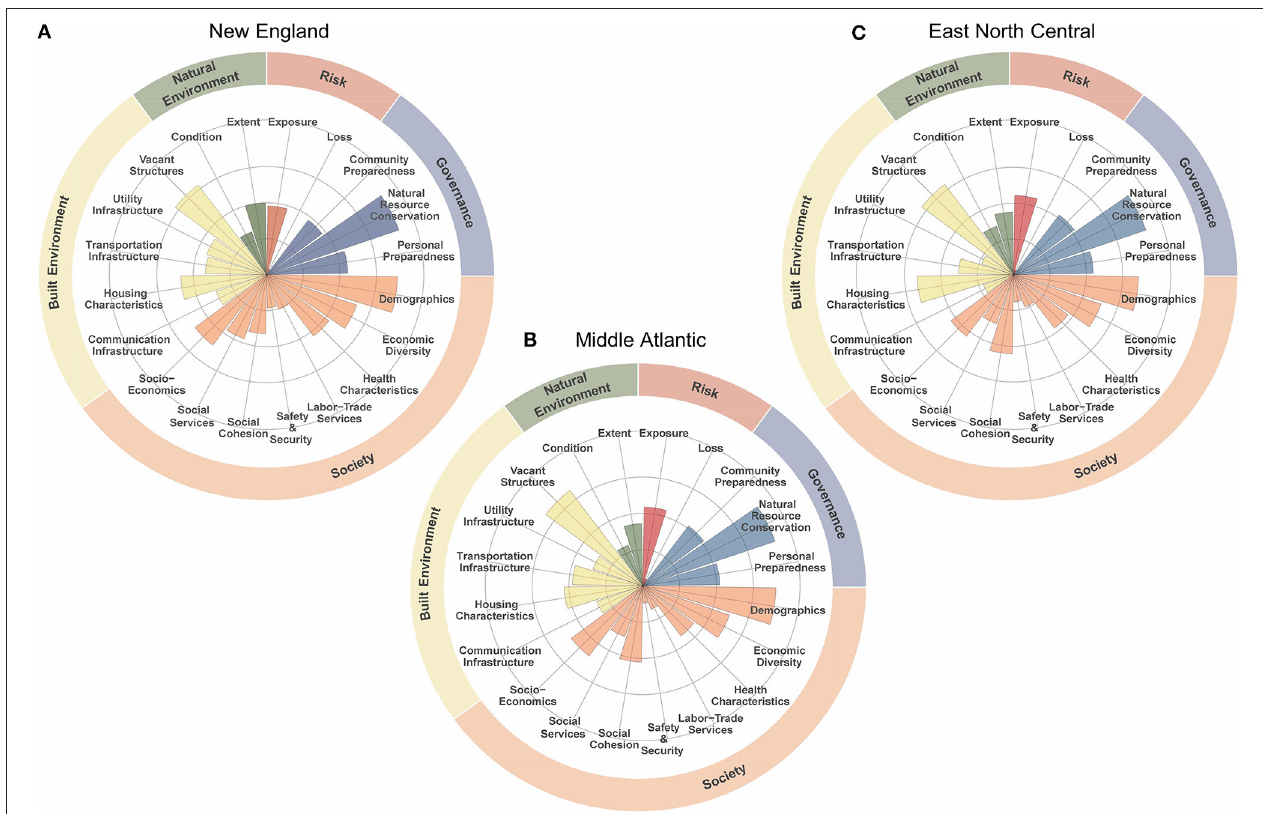
FIGURE 5 | Polar plots of the (A) New England, (B) Middle Atlantic, and (C) East North Central regions.